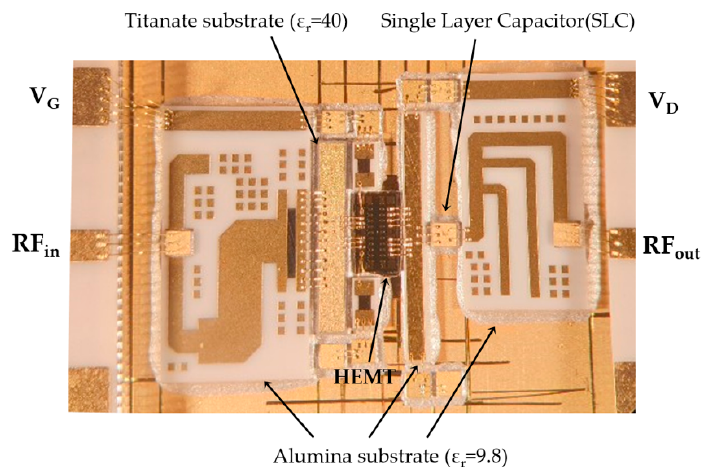
Figure 8. Fabricated internally matched power amplifier using a GaN HEMT bare die, input/output thin-film matching substrates, and single-layer capacitors (circuit area = 9.9 mm × 6.8 mm).